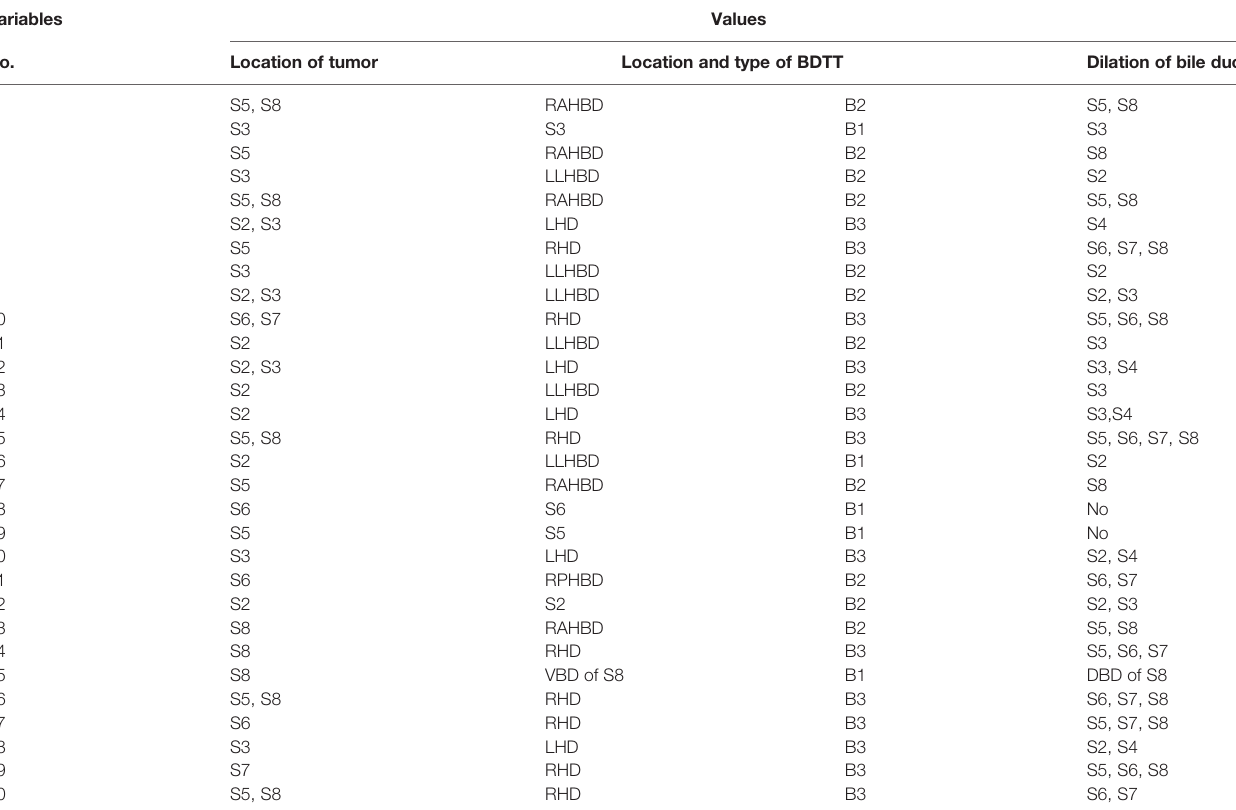
TABLE 2 | Imaging fi ndings of 30 HCC patients with type B1 – B3 BDTT. Variables Values No. Location of tumor Location and type of BDTT Dilation of bile